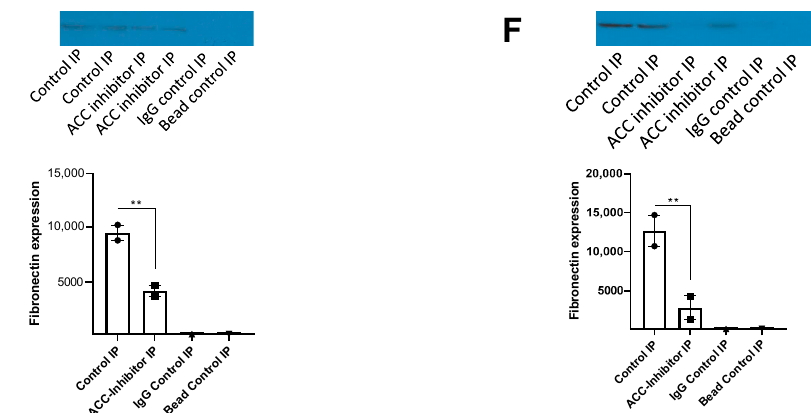
Figure 7. Decreased expression of Fibronectin with ACC blockade. Expression of fibronectin is diminished by knocking out of ACC1 and 2 encoding genes using CRISPR/Cas9 gene knock out in podocytes ( A ) and BUMPT cells ( B ); by exposure to Acaca and Acacb GapmeRs (2 uM) in podocytes ( C ) and BUMPT cells ( D ); and by exposure to firsocostat (2 uM) in podocytes ( E ) and BUMPT cells ( F ). Positive loading control in ( A , B ) are wild-type cells with and without electroporation, in ( C , D ) they are cells exposed to no GapmeR or scrambled GapmeR, and in ( E , F ) they are cells without exposure to ACC-inhibitor. In all panels ( A – E ), negative loading controls are IgG and bead controls. Number of experiments in all panels is 2 except for “Wild-type with electroporation” in ( B ) which had 3 experiments. For ( A , B ), wild-type cells with and without electroporation were used as two separate positive controls. Values are mean and standard error. * p < 0.05, ** p ≤